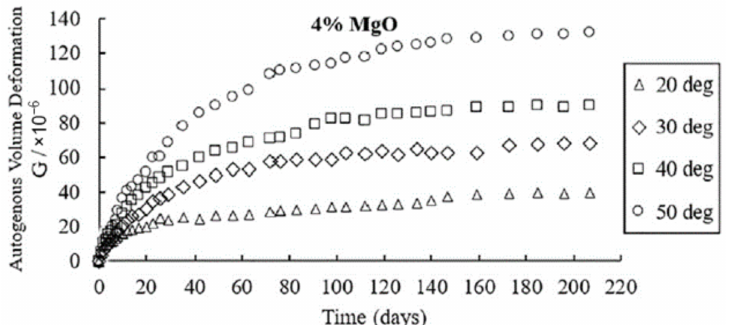
Figure 7. The influence of temperature on the autogenous deformation of concrete mixed with 4% MgO (reprinted with permission from Ref. [62], 2019, Elsevier).